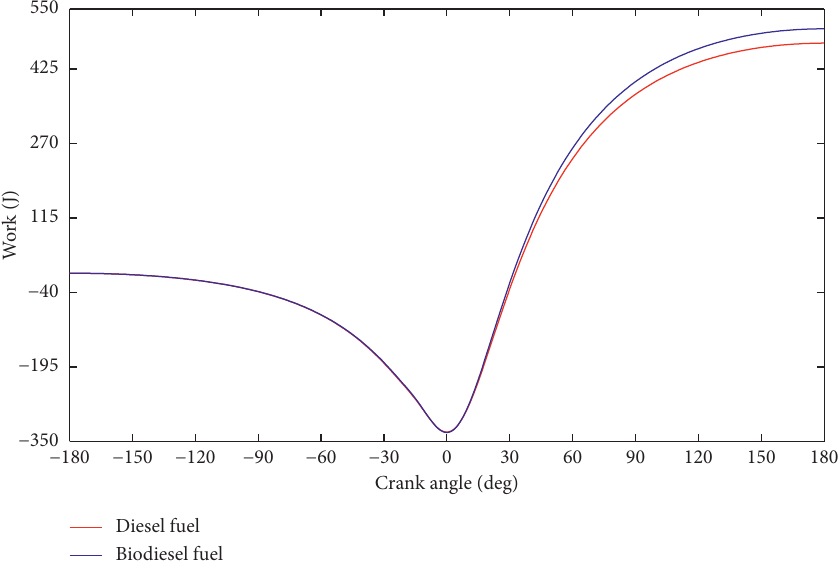
Figure 7: Work comparison of biodiesel and diesel fuels.